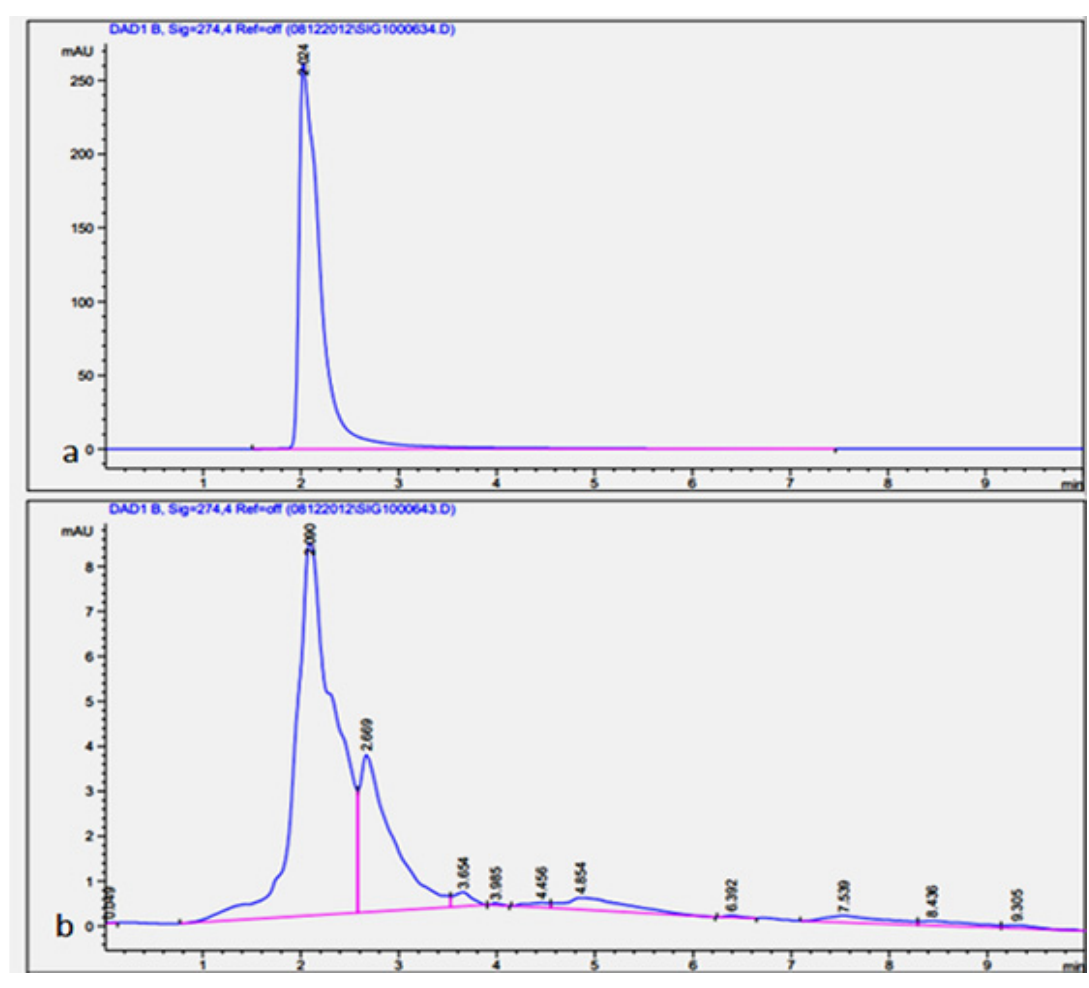
Figure 2. ( a ) HPLC chromatogram of the reference standard of gallic acid (at 274 nm). ( b ) HPLC chromatograms of the phenolic compound in the plant extract (at 274 nm) shows a retention time at 2.0 min.